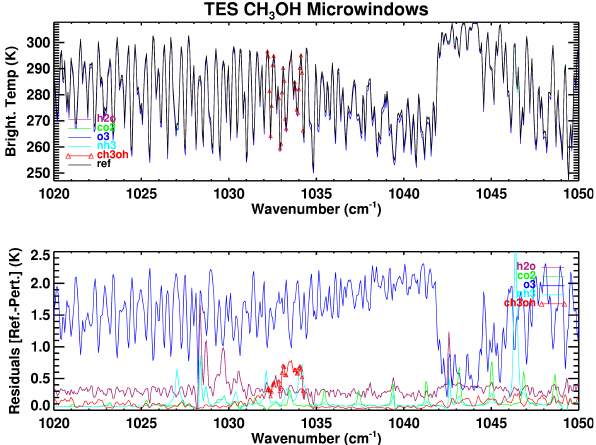
Fig. 1. TES simulated spectra and residuals. Top panel: TES simu- lated spectra for background amounts of H 2 O, CO 2 , O 3 , NH 3 , and CH 3 OH (black line), and for enhanced amounts of each molecule (colored lines). Note that in several cases the perturbed spectra are obscured by the reference spectrum. Bottom panel: residuals computed as the reference spectrum minus the perturbed spectra. In both panels the red triangles show the microwindows used for the methanol retrieval. See Table 1 for background and enhance amounts.